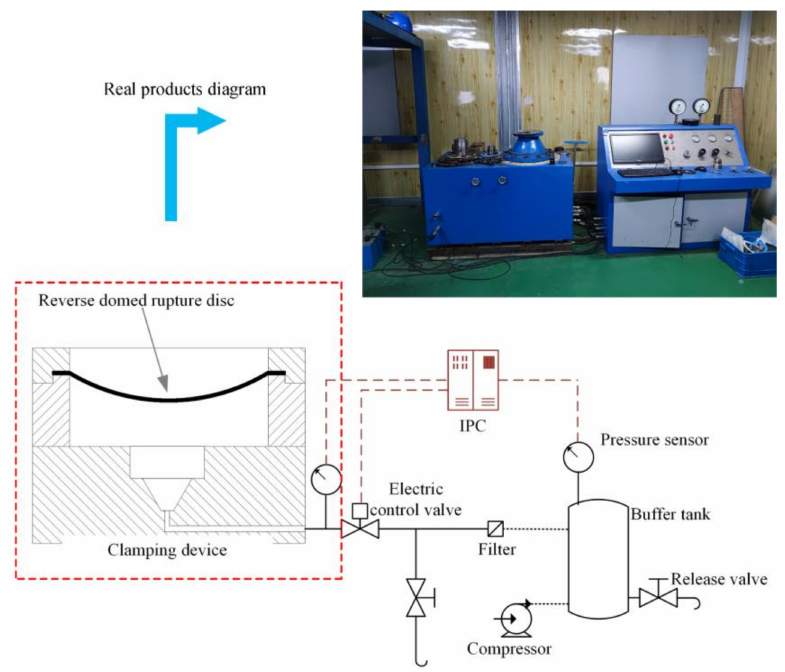
Figure 6. Schematic diagram of the experimental equipment.